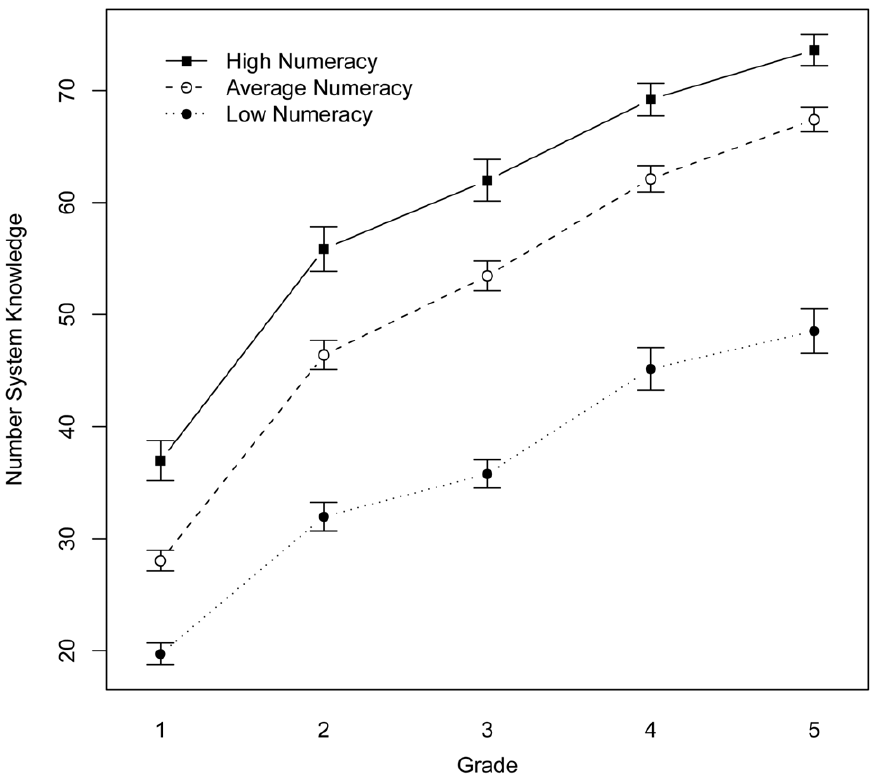
Figure 2. Growth in Number Systems Knowledge across grades for the bottom (Low), two middle (Average), and top (High) quartiles on the seventh grade numeracy measure. The score is the percentage of the maximum possible score across the four tasks that composed the Number System Knowledge factor.